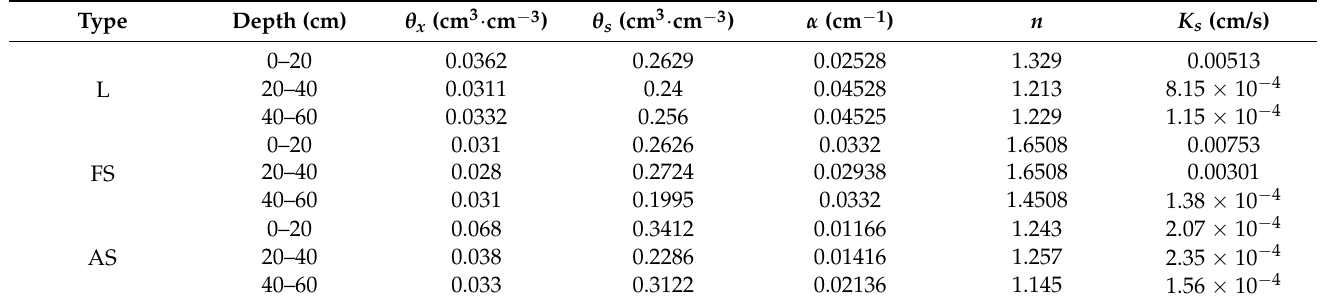
Table 4. Local minimum values of hydraulic parameters for different